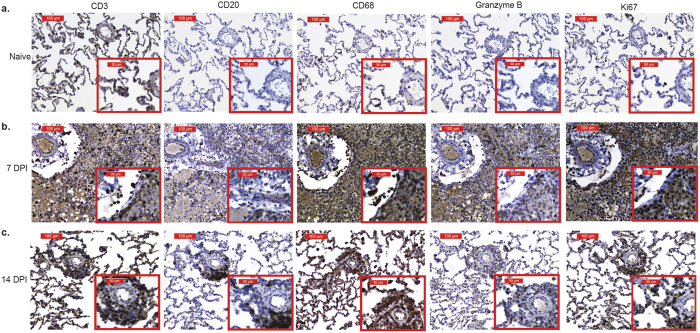
Immune cells proliferate and exhibit cytotoxicity in SVV infected lungs.CD3, CD20, CD68, granzyme B and Ki67 staining in lung sections from (a) naïve, (b) 7 DPI and (c) 14 DPI at 20X and 40X magnification.